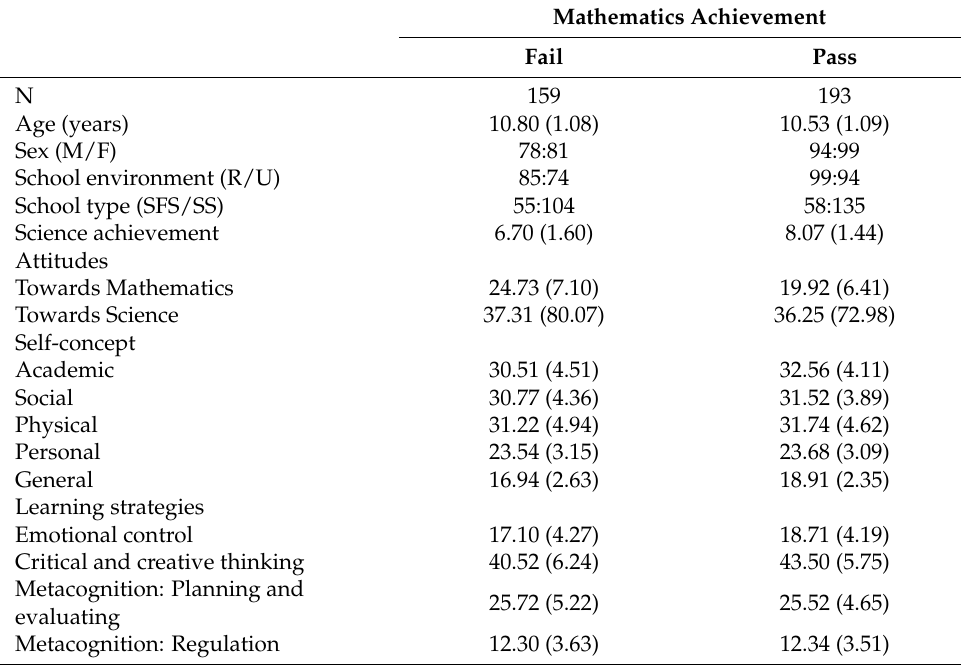
Table 1. Demographics and study variables of